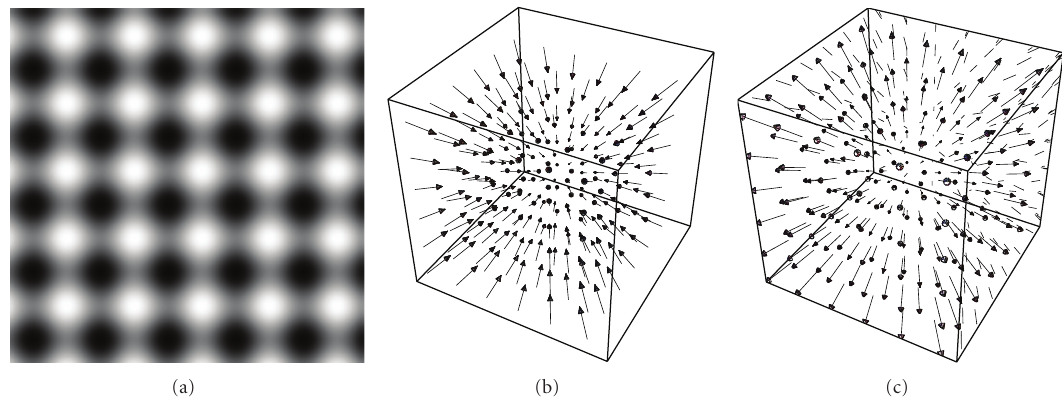
Figure 6: (a) The image shows a 2-dimensional slice of the 3-dimensional artificial phantom. (b) and (c) The images display the vector field of two successive frames of the